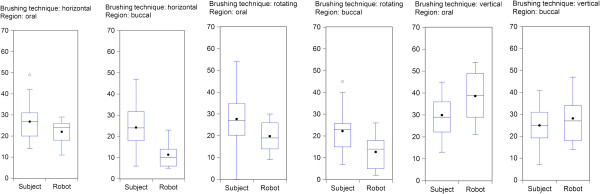
Comparison of different brushing techniques between the robot and the subjects. Cumulative number of not completely cleaned planimetrical fields of teeth 32–47, both toothbrushes and all subjects and robot cycles (total number of fields 9x9 = 81). Explanation: Number of observations: n = 27 subjects; n = 14 robot runs. The mean of a series is depicted using a black point, while the median is drawn as a line through the center of the box. The box represents the middle 50 percent of the data. At both sides it is connected with the last data point within the 1.5* interquartile range from the first resp. third quartile. Data points outside are defined as (°) outliers.